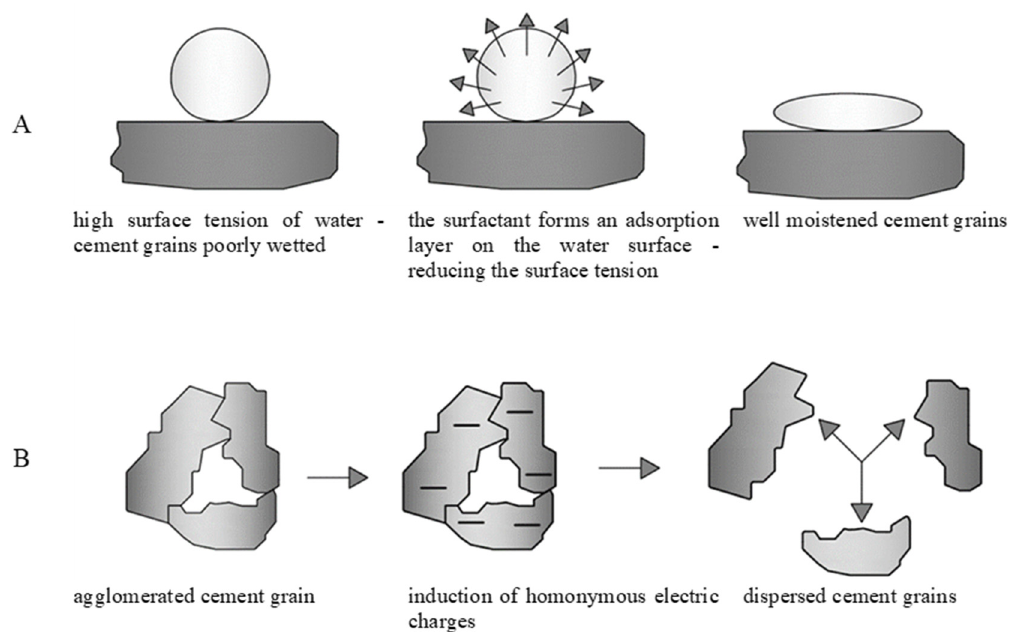
Figure 11. Diagrams of operation of ( A ) the hydrophilic mechanism and ( B ) the dispersant mecha-